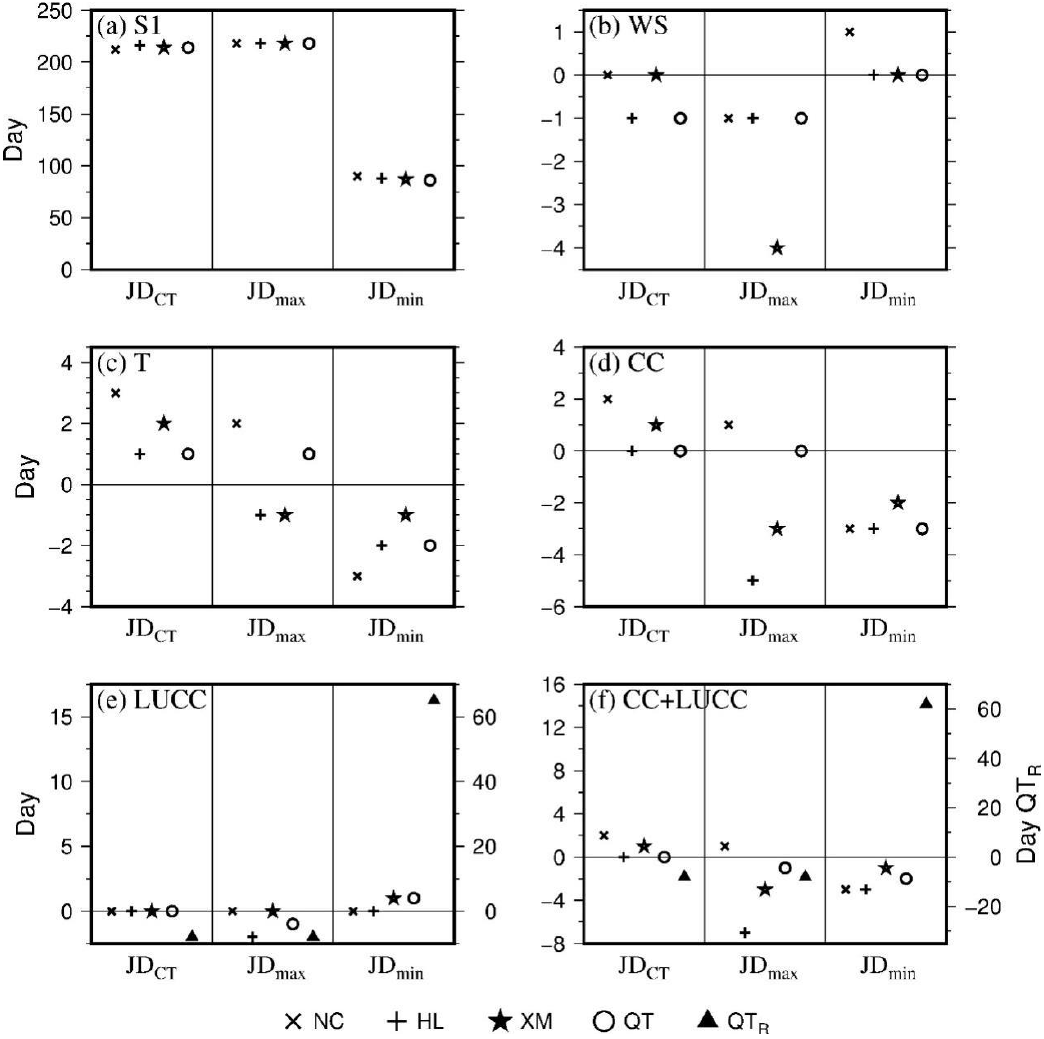
Figure 9. Timings of centroid of streamflow (JD CT ), annual maximum (JD max ), and minimum (JD min ) flow in baseline ( a ), and the impacts of wind speed ( b ), temperature ( c ), climate change ( d ), land use/cover change ( e ), and both climate change and land use/cover change ( f ).